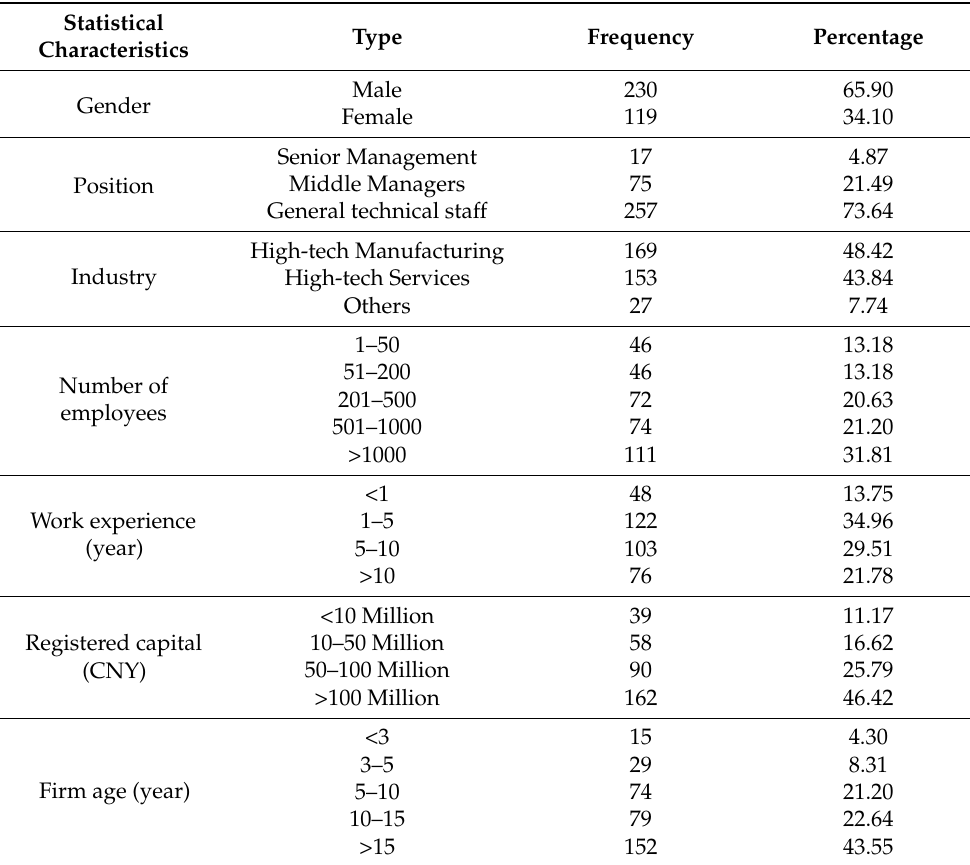
Table 1. The distribution characteristics of the